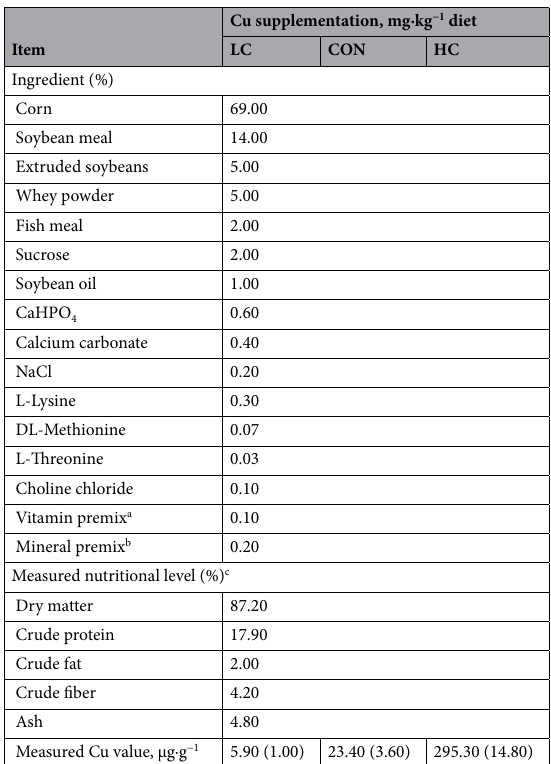
Table 3. Composition of the experimental diets [Mean (SD)]. a The vitamin premix provided per kilogram of diet: vitamin A, 10,000 IU; vitamin D 3 , 2500 IU; vitamin K 3 , 3.0 IU; vitamin B 5 , 40 mg; nicotinic acid, 60 mg; folic acid, 1 mg; biotin, 0.2 mg; vitamin B 6 , 4.0 mg; vitamin B 2 , 7.5 mg; vitamin B 1 , 5.0 mg; vitamin B 12 , 0.08 mg. b The mineral premix provided per kilogram of diet: Zn (ZnSO 4 ·H 2 O), 100 mg; Cu (CuSO 4 ·5H 2 O), 125 mg; Mn